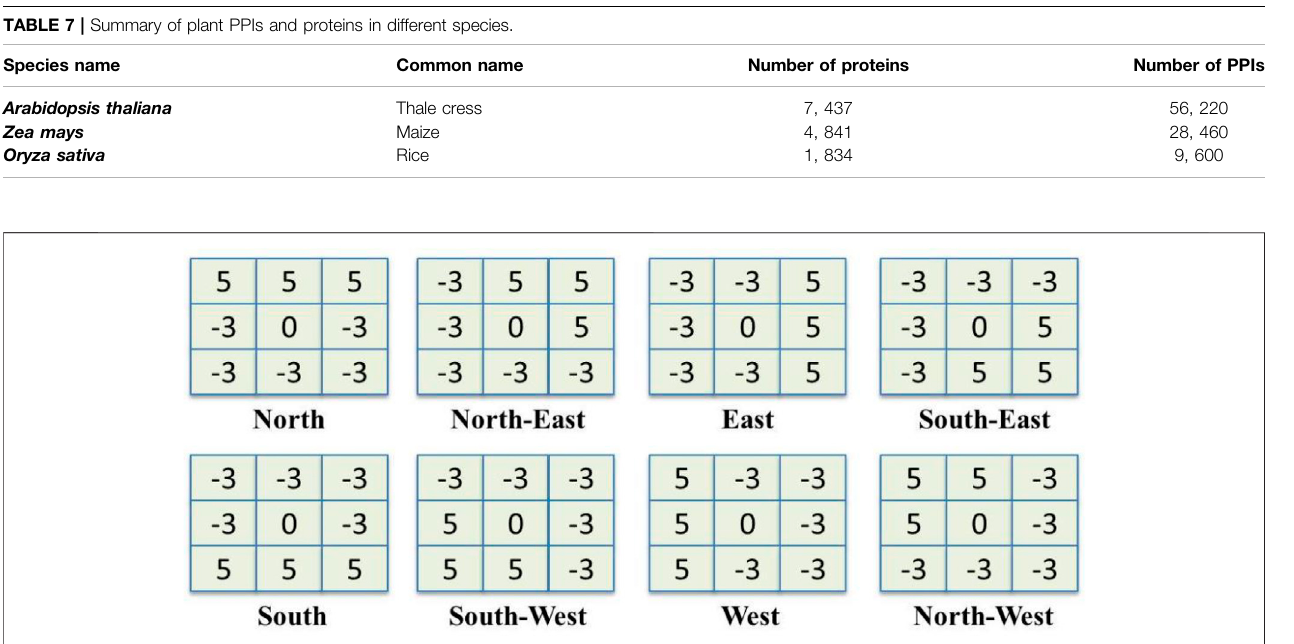
FIGURE 4 | The masks of Kirsch ’ s edge detector which is used for calculating responses in eight possible directions.